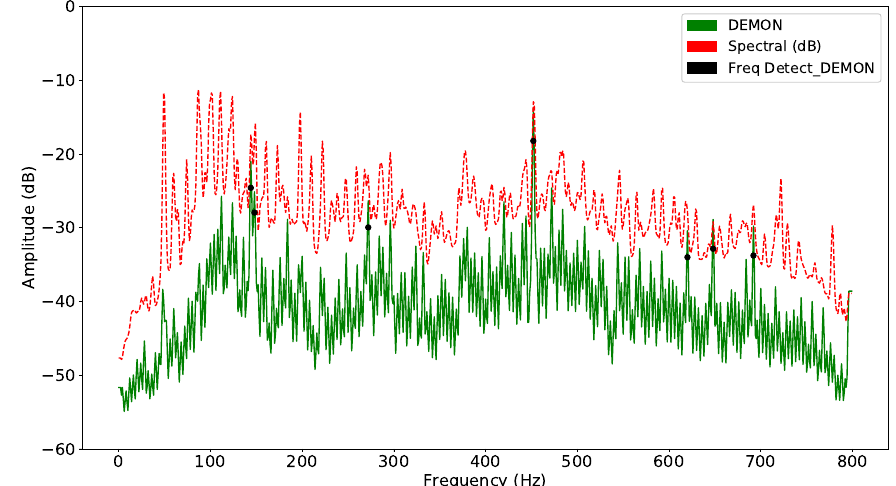
Figure 5. Signal frequency detection by DEMON with